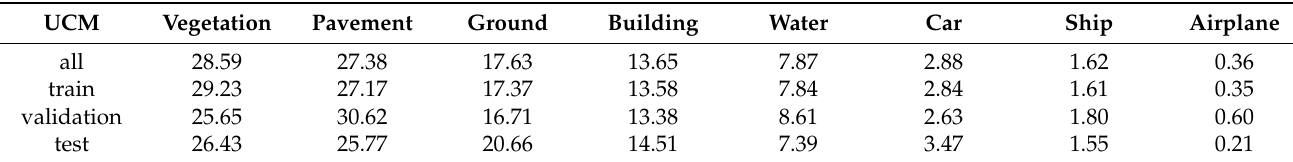
Figure 5. Raw images and ground truth masks of the UCM dataset. Table 1. The class distribution for the UCM dataset (%). Table 2. The class distribution for the DeepGlobe dataset (%).